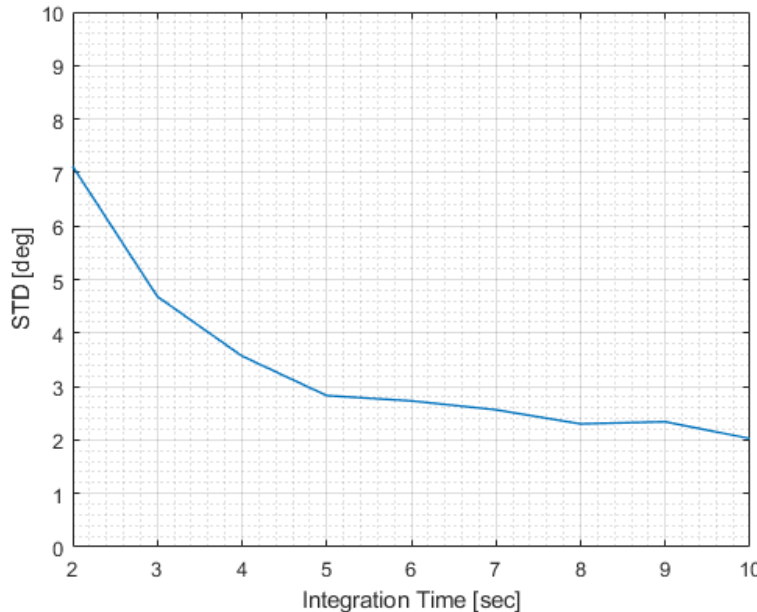
Figure 9. AOA standard deviation versus measurement integration time.